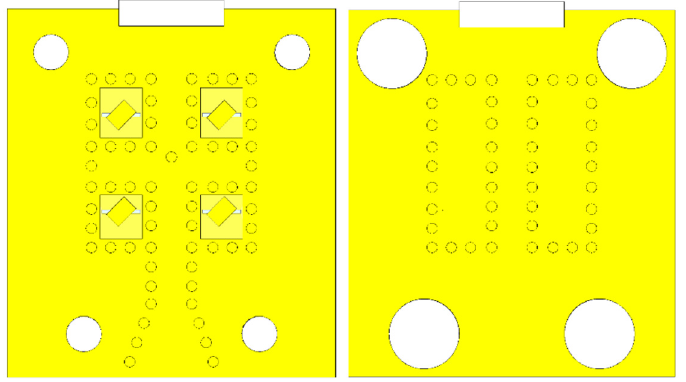
Figure 2. Positions of the SIW vias in the top layer ( left ) and the bottom layer ( right ). The array was designed to radiate a left-handed circularly polarized wave (LHCP)